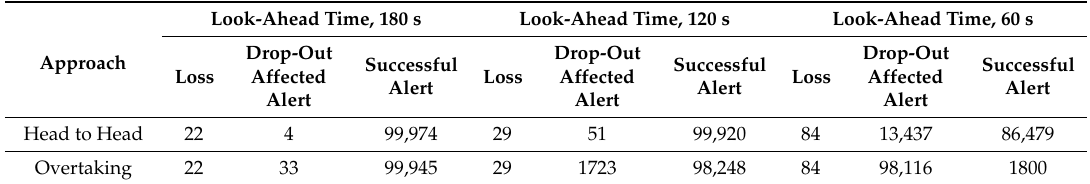
Table 7. Summary of